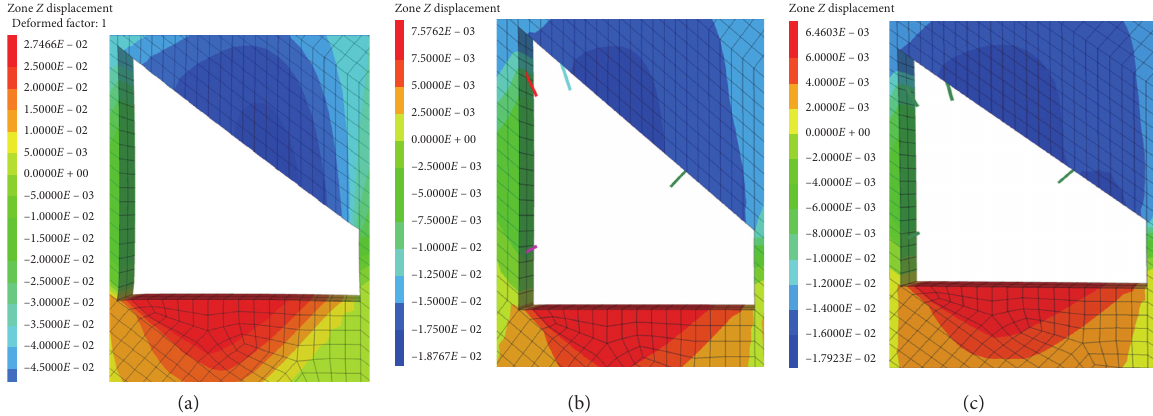
Figure 9: Maximum subsidence of roadway roof under different support forms. (a) No support state. (b) Supporting state of non-truss anchor cable. (c) Support state of truss anchor